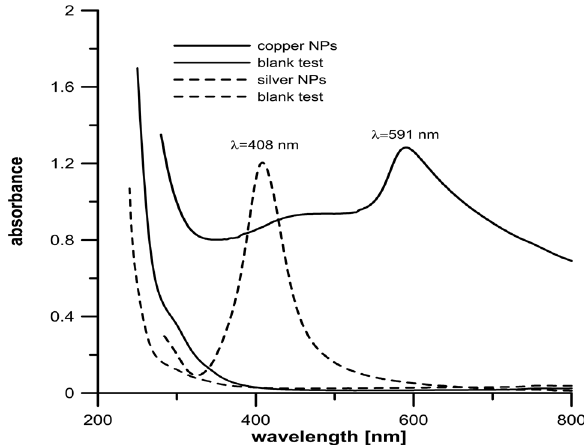
Figure 5: UV–vis absorbance spectra of two nanoparticle solutions: